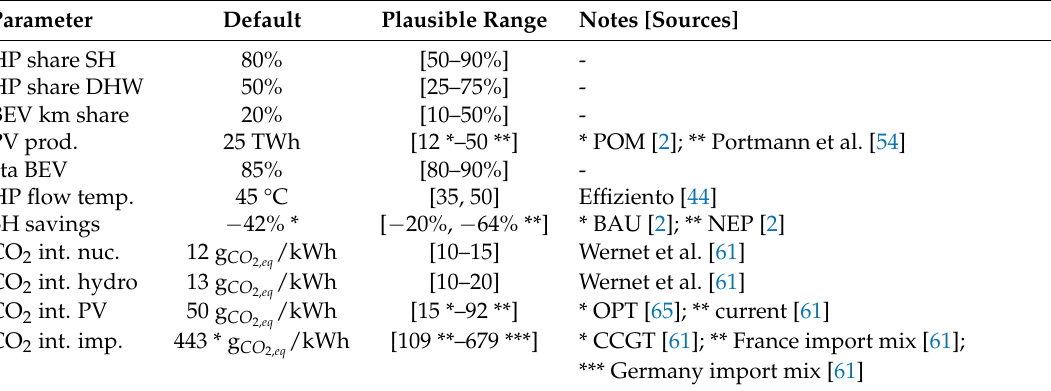
Table 3. Key parameters of this study with their default and plausible range of values. “ HP